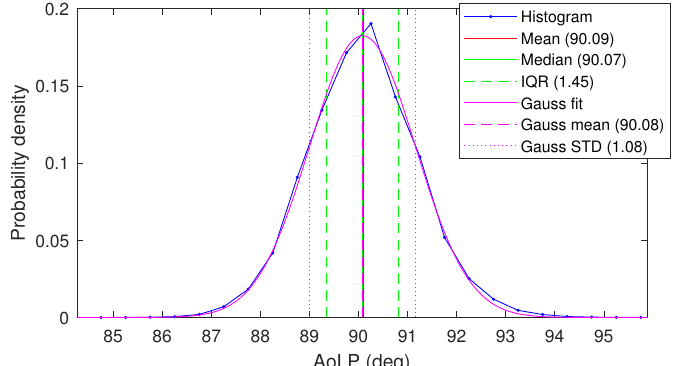
Figure 12. Histogram for the large ROI of Figure 11 in a similar format to the case of Figure